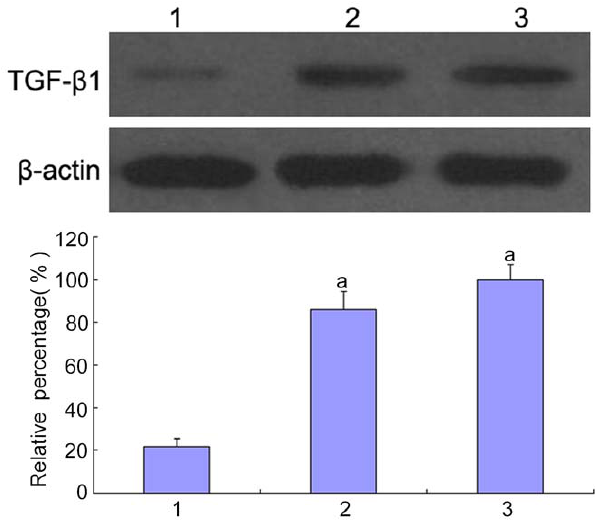
Figure 1. The expression of TGF- b 1 in HK-2 cells by Western blot. TGF- b 1 was measured by Western blot of the HK-2 cells cultured in 5.5 mM glucose (lane 1), 30 mM glucose for 24 h (lane 2), 30 mM glucose for 48 h (lane 3). a P , 0.05 vs. 5.5 mM glucose.